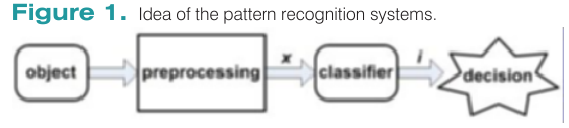
Figure 1. Idea of the pattern recognition